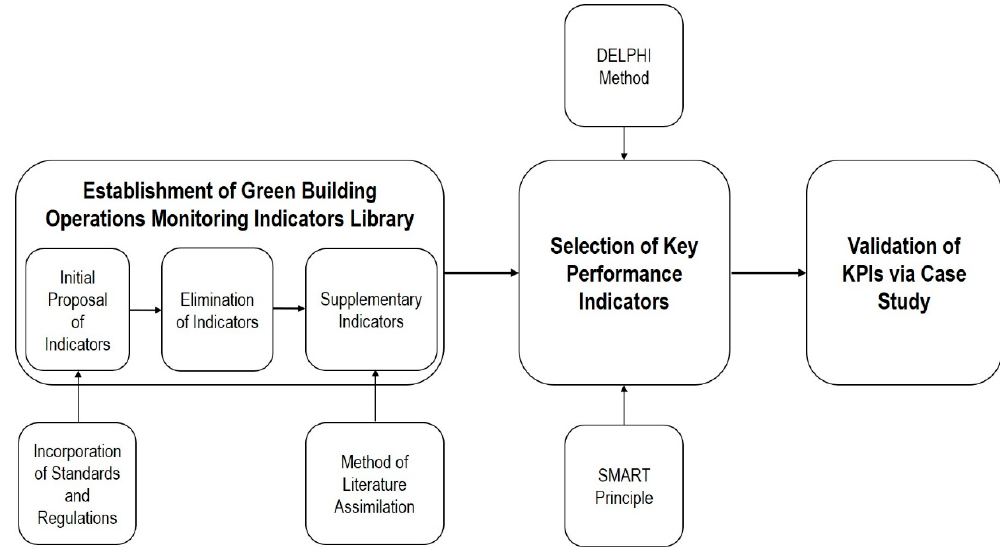
Figure 1. Illustration of the research methodology.